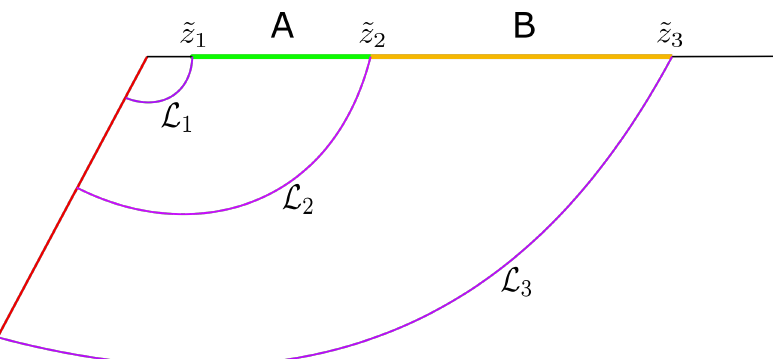
Figure 20. Geodesics contributing to the holographic entanglement negativity of adjacent intervals in